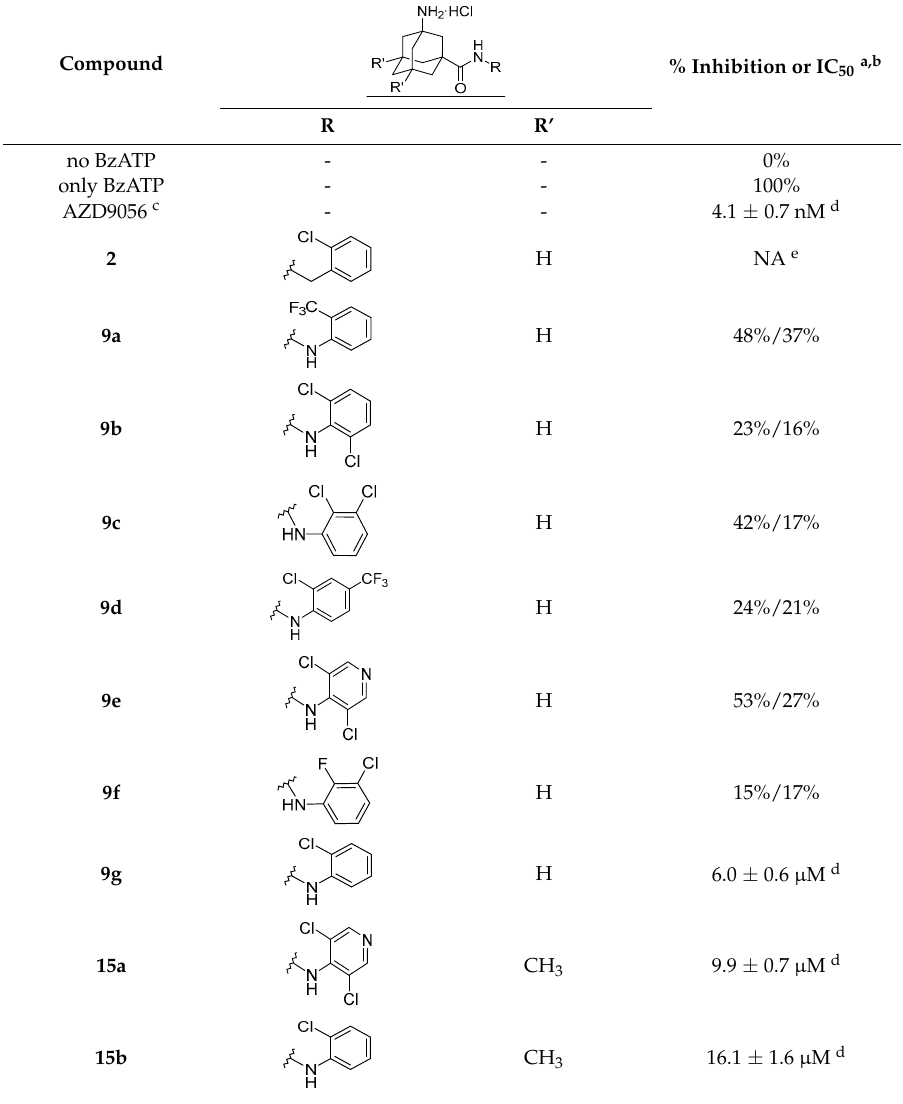
Table 1. Antagonistic activity in h P2X7-expressing HEK293 cells a .